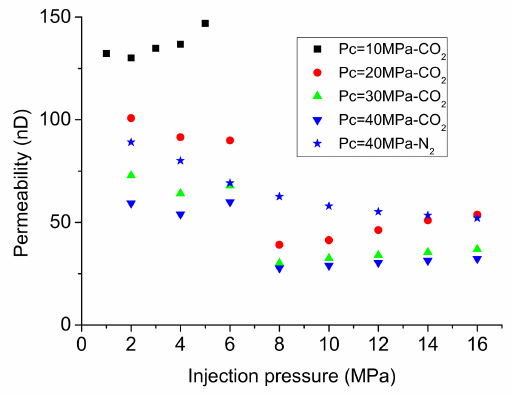
Figure 5. Relationship between the calculated permeability to CO 2 and N 2 and injection pressure under steady-state